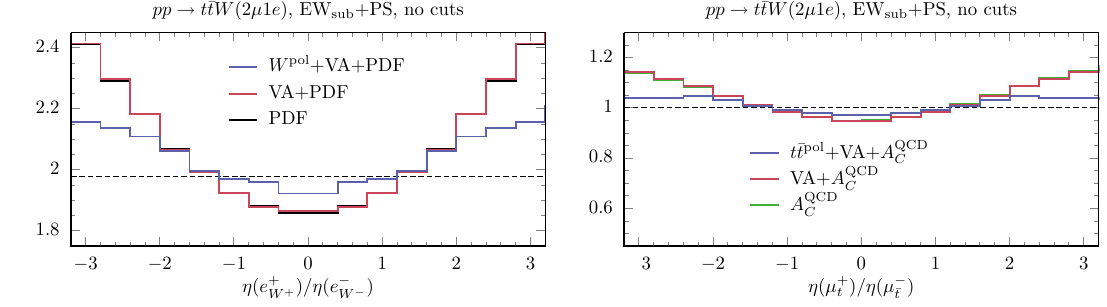
Fig. 5 Origin of asymmetries in W associated (left) and top-quark pair (right) decay products for the EW sub perturbative orders